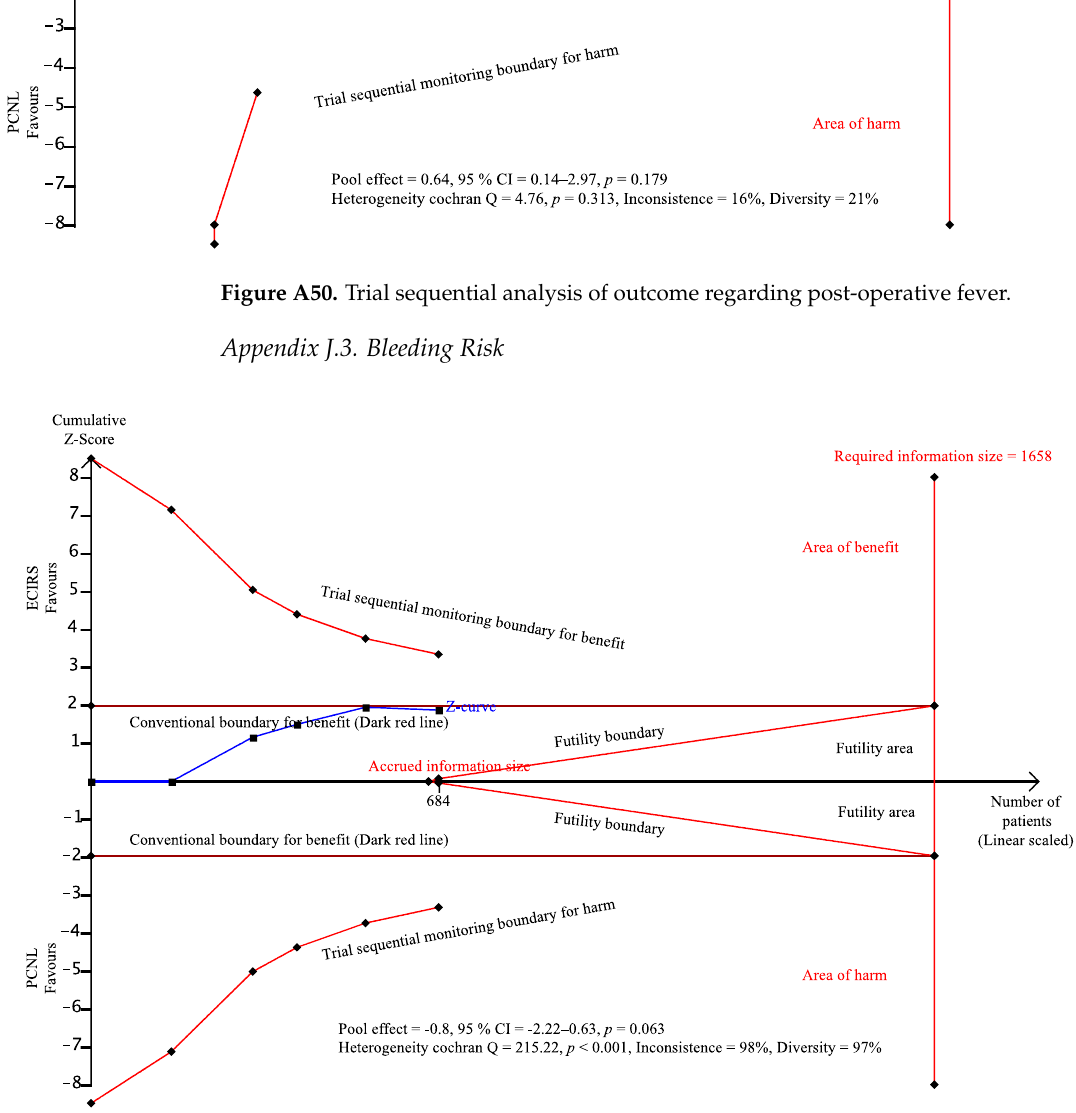
Figure A51. Comparison-adjusted funnel plot in outcome for hemoglobin drop.